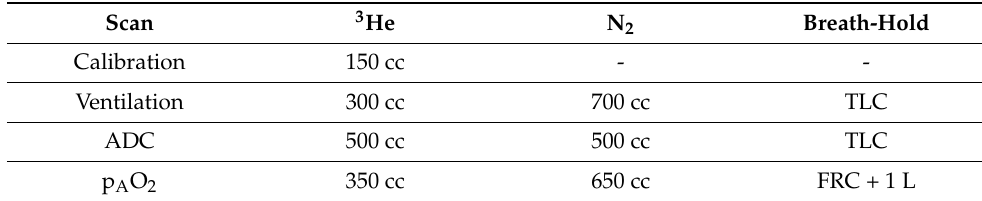
Table 2. Gas composition for imaging